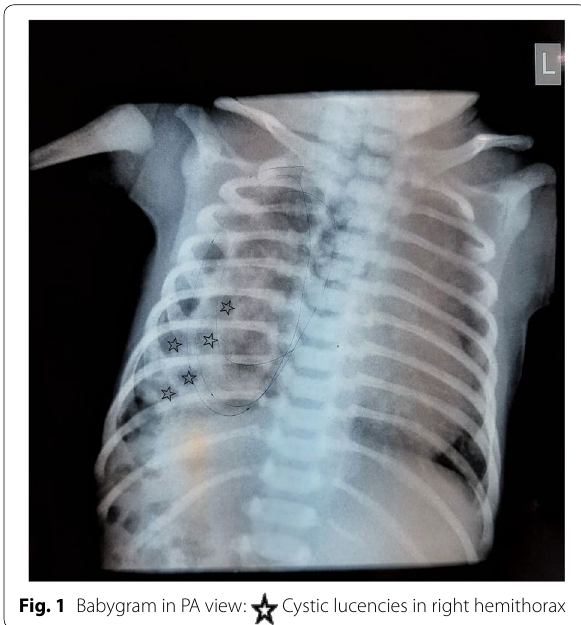
Fig. 1 Babygram in PA view: Cystic lucencies in right hemithorax